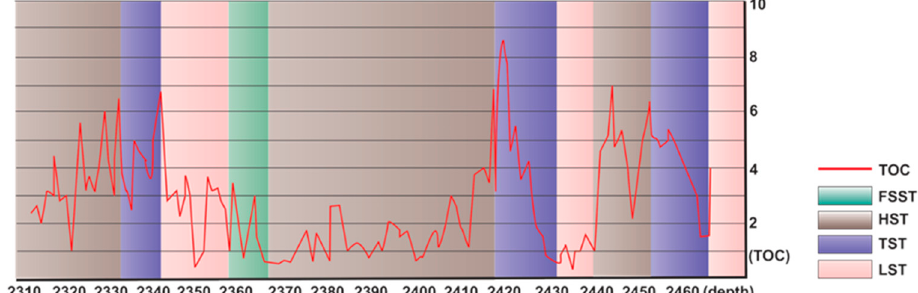
Figure 8. The relationship between systems tract and TOC content.